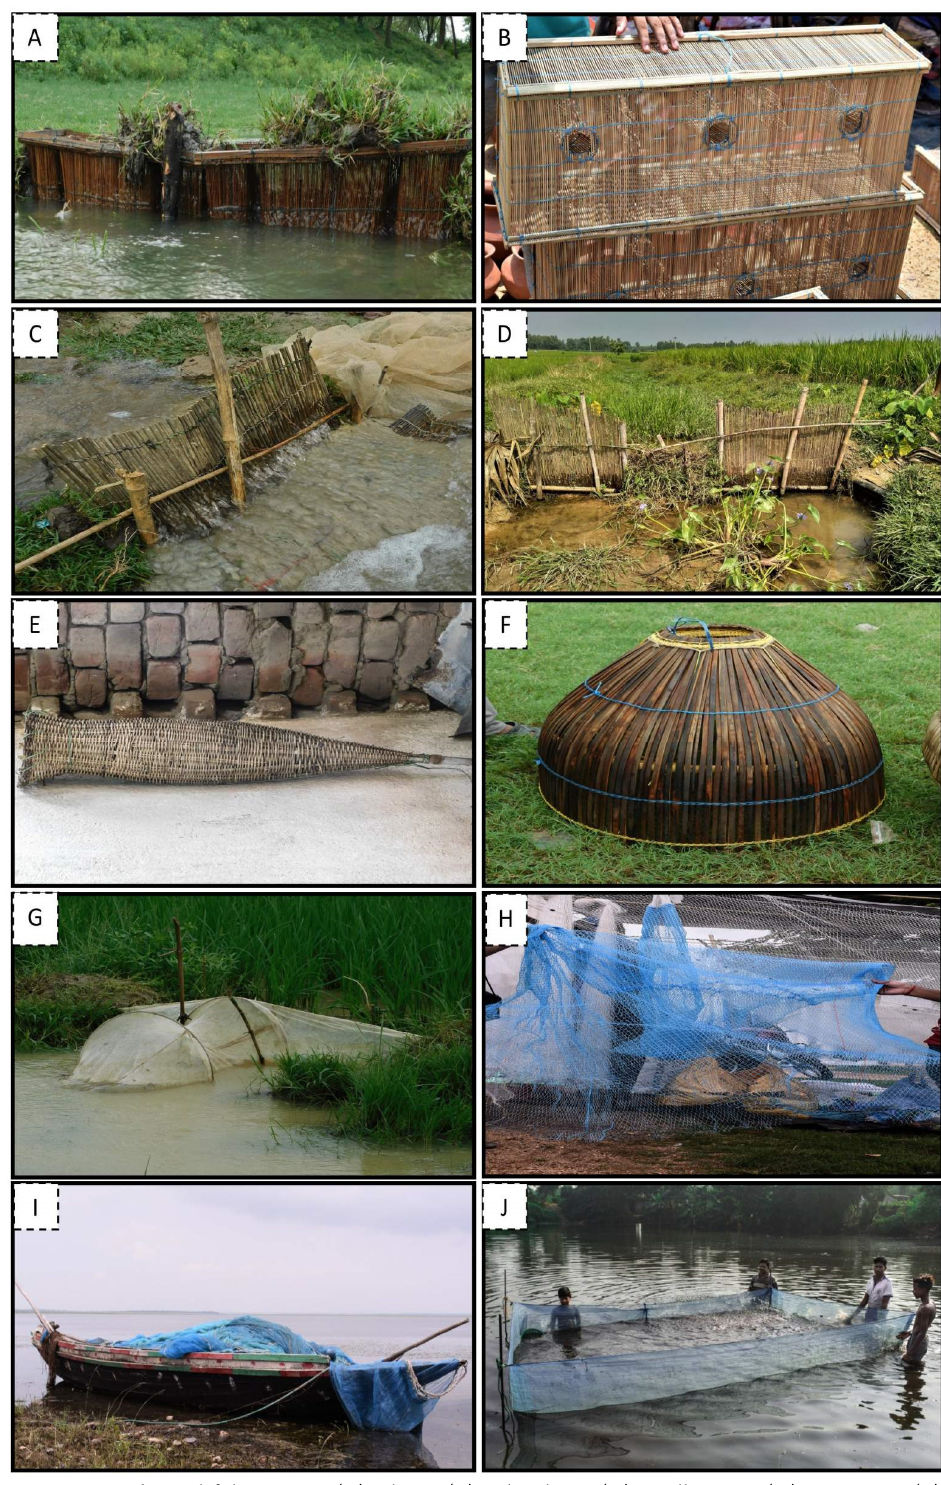
Figure 3. Traditional fishing gears: (A) Ghu ṇ i; (B) Raba ghuni; (C) Small Si ẏ ā ṛ ā; (D) Big Si ẏ ā ṛ ā; (E) Ghugī; (F) Palu'I; (G) Chākani jāla; (H) Ghugī jāla; (I) Maśāri jāla; (J) Maśāri